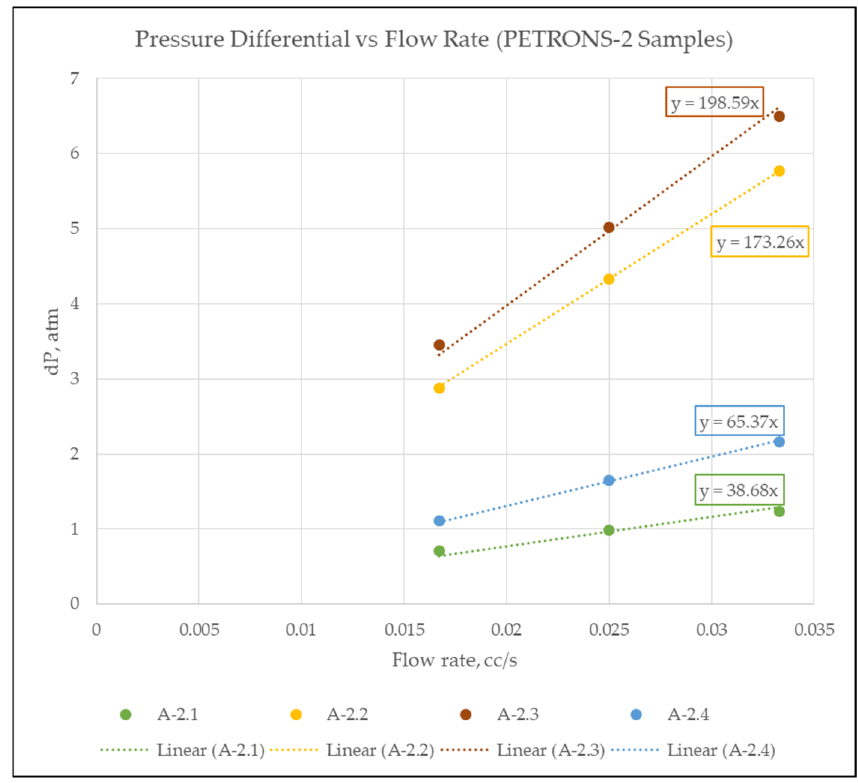
Figure 13. Graph of pressure differential against brine flow rate for PETRONS-2 samples.